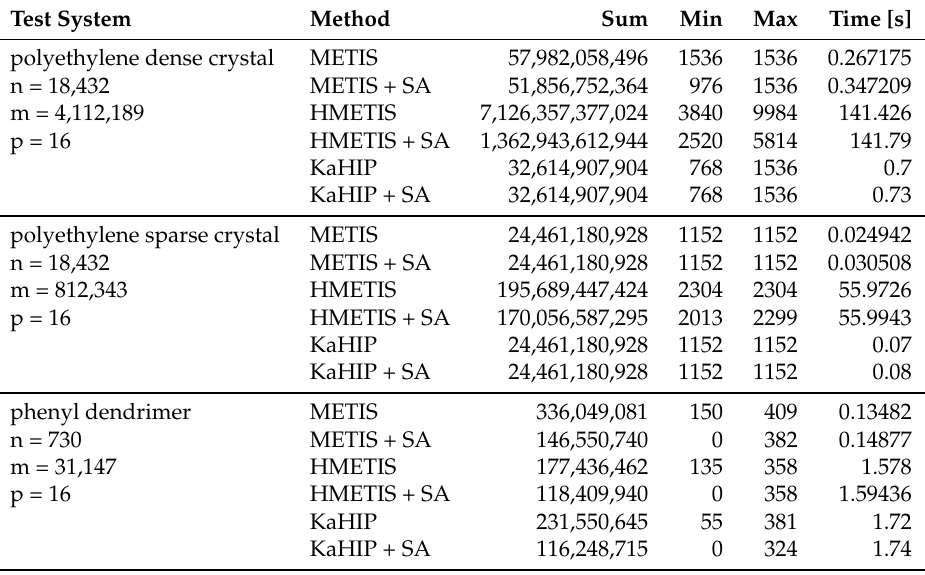
Table A1. Various test systems (first column) evaluated by different partition schemes (second column; number of vertices n , edges m , and blocks p are given). Results measured with the sum of cubes (3) criterion (sum), the sum of size and halo for the smallest CH-partition (min) as well as the biggest CH-partition (max), and the overall runtime (in seconds) are given in columns